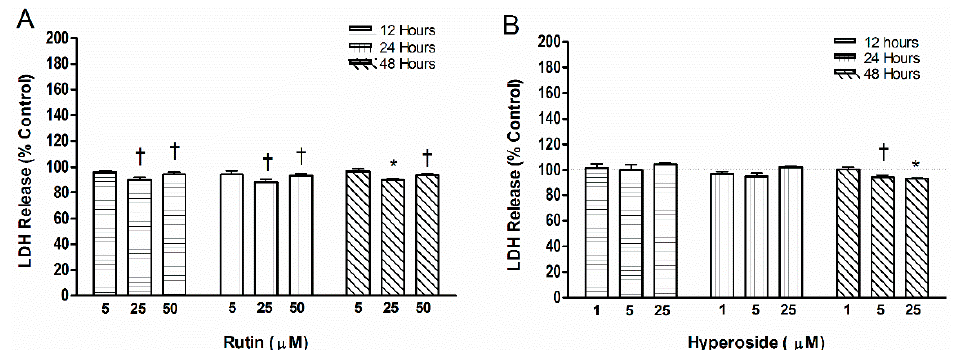
Figure 4. Lactate dehydrogenase (LDH) release by addition of ( A ) rutin or ( B ) hyperoside. LDH activity was measured by the reduction of NAD + to aid in the conversion of a tetrazolium dye to a formazan crystal. Significant differences are indicated by: † p < 0.05, and * p < 0.001 compared to control within a day. Each bar represents n = 6.